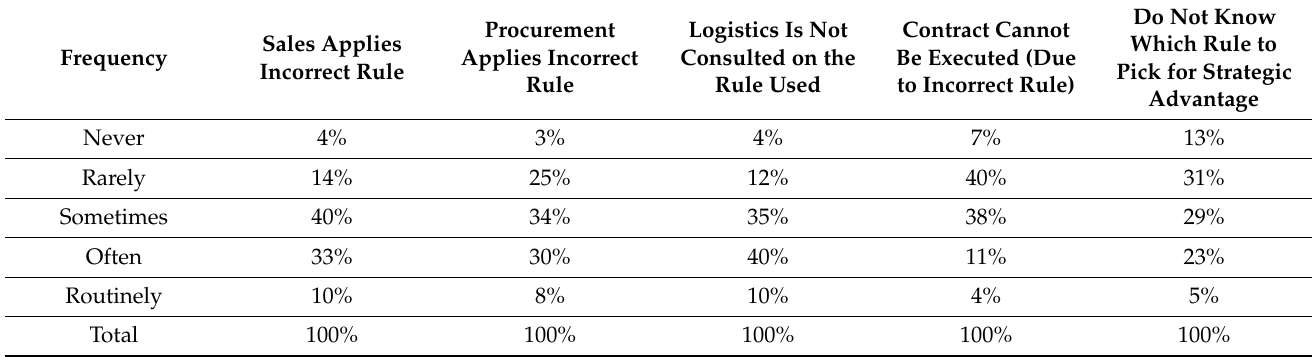
Table A2. Issues Reported with Incoterm ®